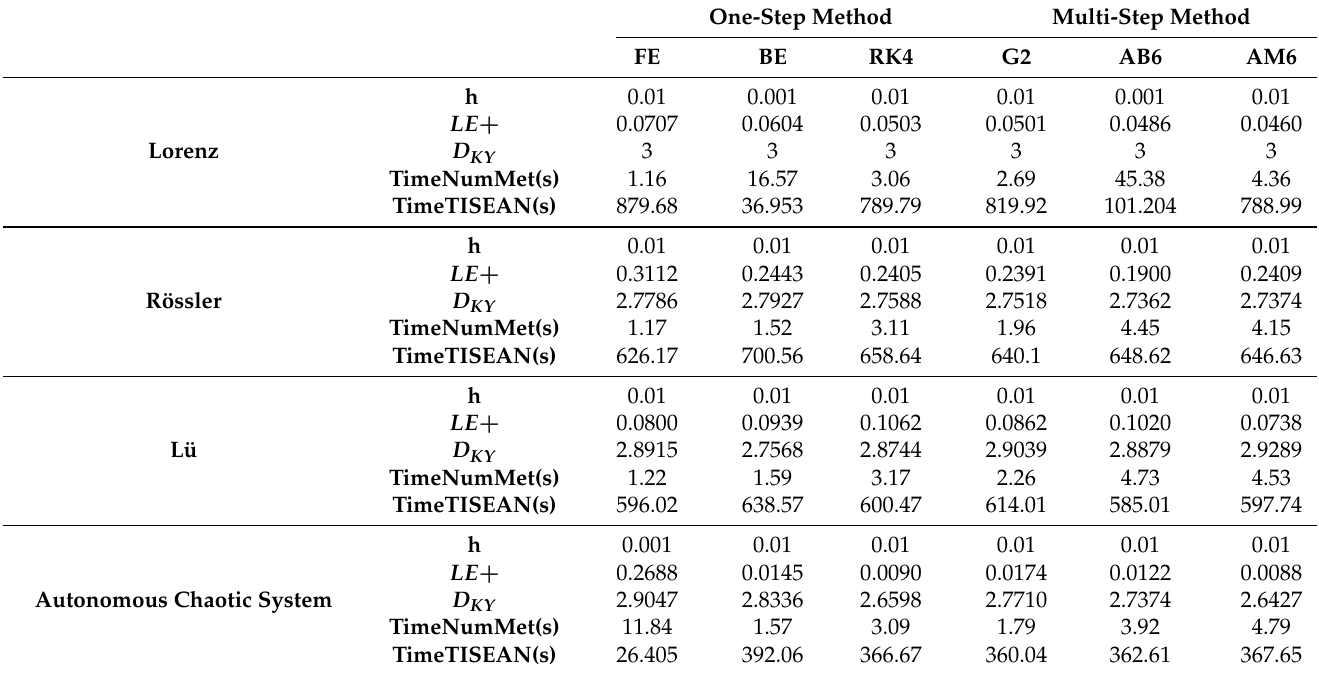
Table 4. LE + and D KY of (1)–(5) using a small h .